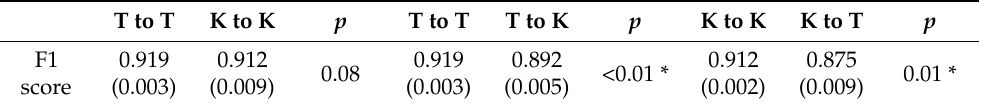
Table A1. Performance of glomerular detection.